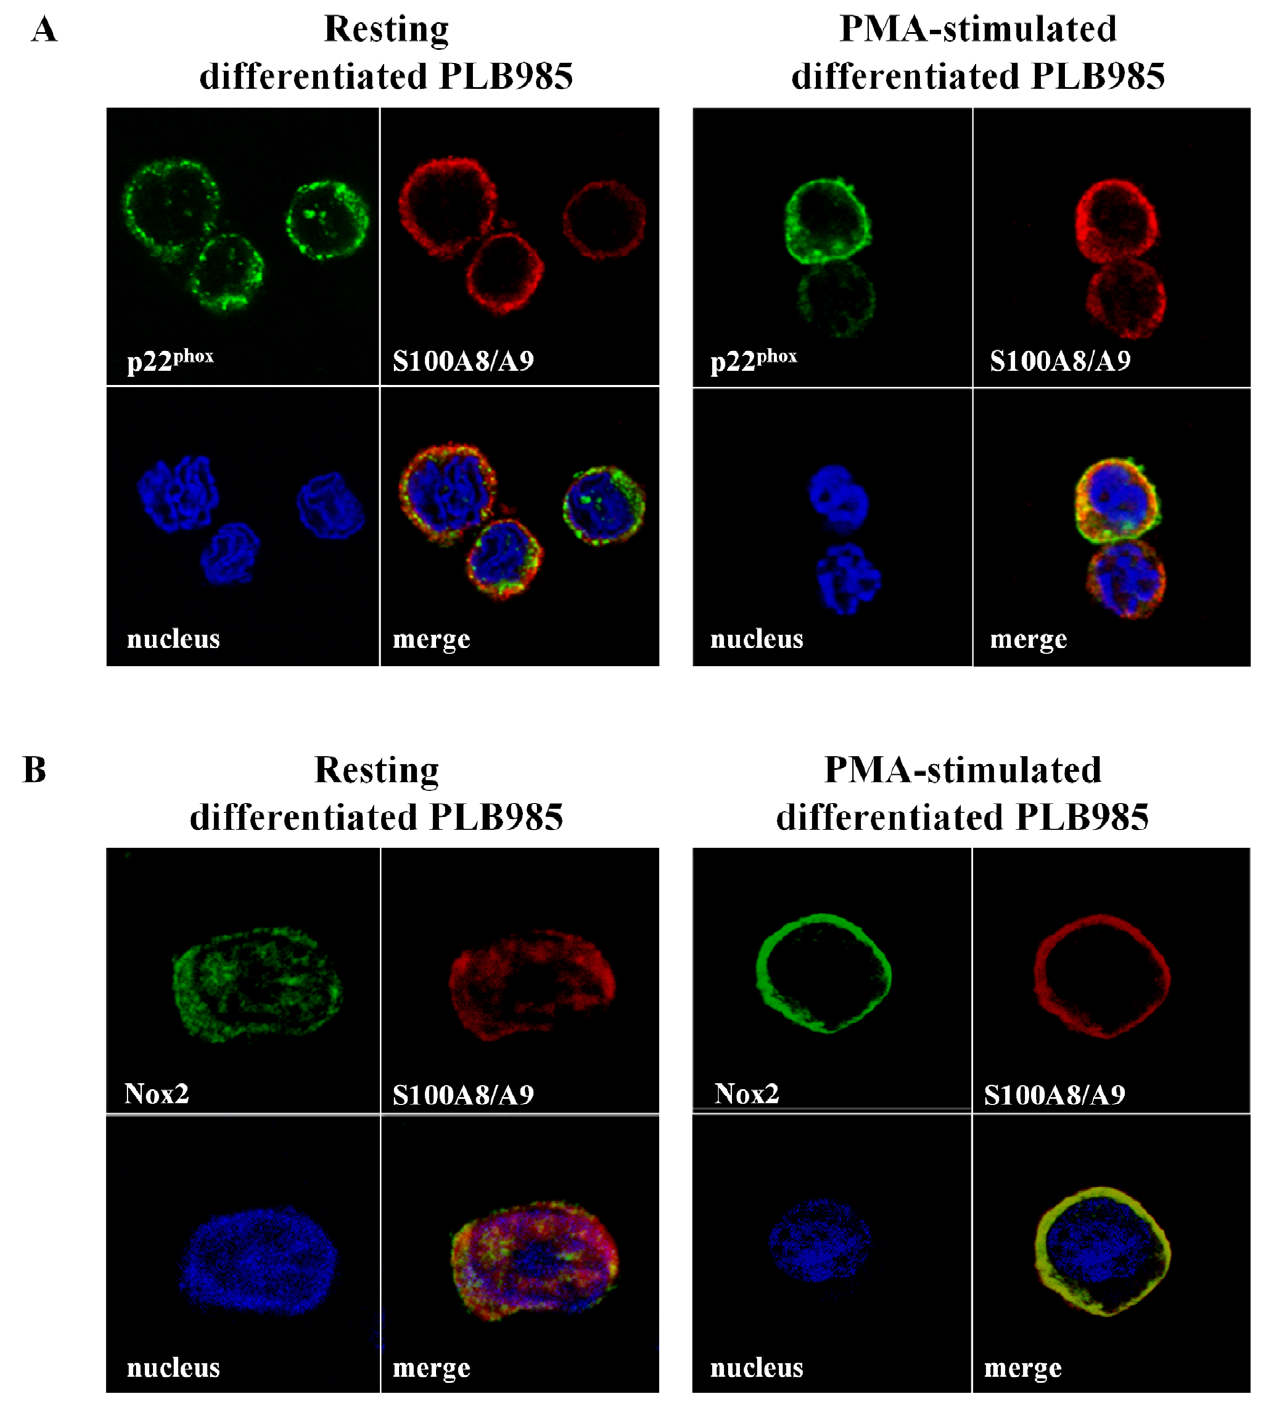
Figure 8. Co-localization of p22 phox or Nox2 with endogenous S100A8/S100A9 in PLB985 differenciated cells illustrated by confocal microscopy. Resting or PMA-stimulated differentiated PLB985 cells were incubated on poly-L-lysine-coated cover slips. They were fixed with 4% (w/v) paraformaldehyde and then permeabilized with 0.1% (w/v) 6 100 Triton as described in Materials and Methods. Permeabilized cells were co-labeled with a polyclonal anti-p22 phox IgG [31] and a 2H9 monoclonal antibody anti-S100A9 (A) or co-labeled with a 13B6 monoclonal anti- Nox2 and a polyclonal anti-S100A8/A9 [32] (B) to investigate the co-localization of cytochrome b 558 with endogenous S100A8/A9 proteins. A) Green, p22 phox and red, S100A8/A9. B) Green, Nox2 and red, S100A8/A9. Cell nuclei were stained in blue with Hoechst 33258. The figure represents one experiment out of three performed.